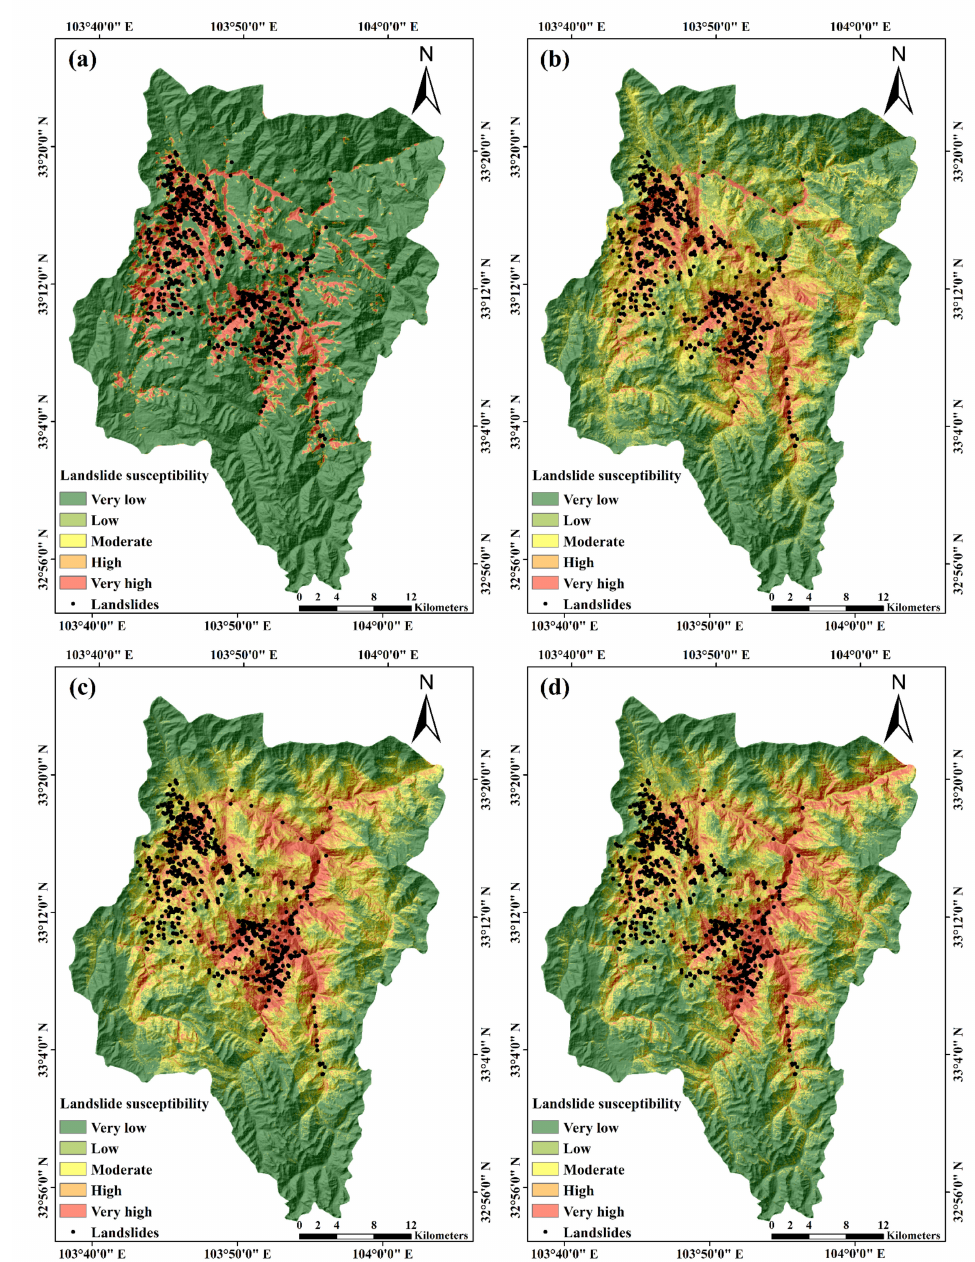
Figure 10. Landslide susceptibility maps of Zhangzha Town using ( a ) convolutional neural network, ( b ) random forest, ( c ) logistic regression, and ( d ) support vector